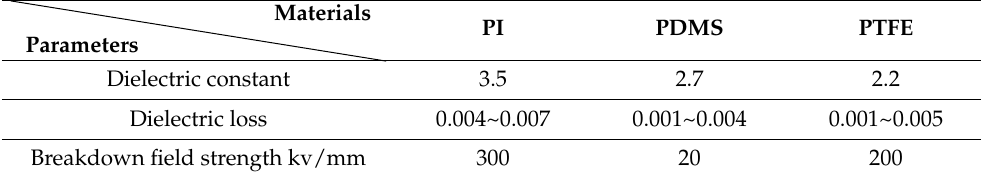
Table 2. Flexible material performance parameters.